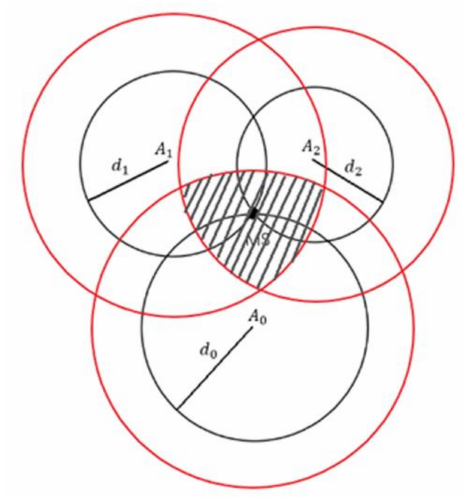
Figure 4. Improved trilateration